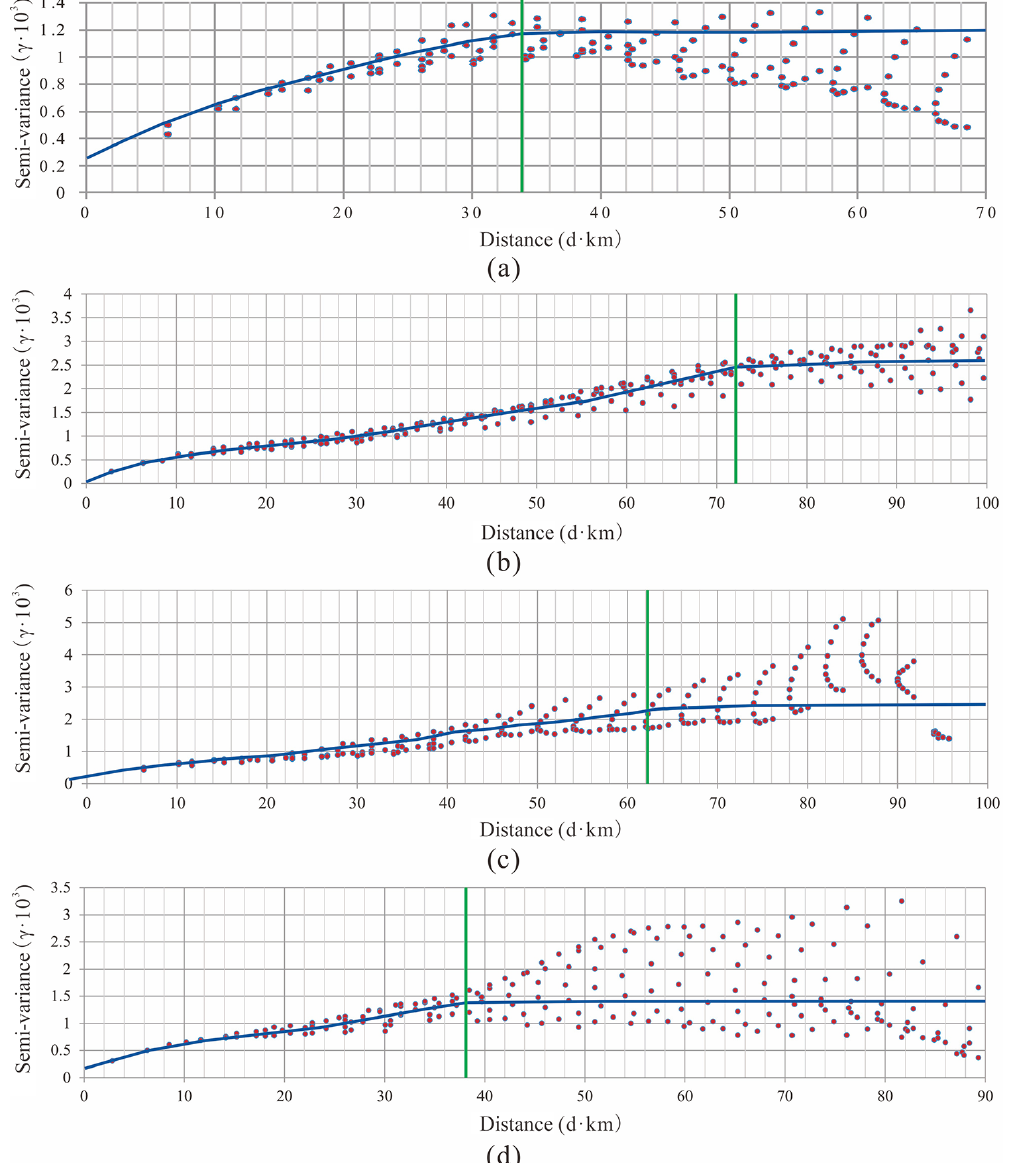
Figure 7. Experimental variogram fitting in different directions; the green lines denote the variable ranges determined for azimuths of (a) 0 ◦ , (b) 45 ◦ , (c) 90 ◦ , and (d) 135 ◦